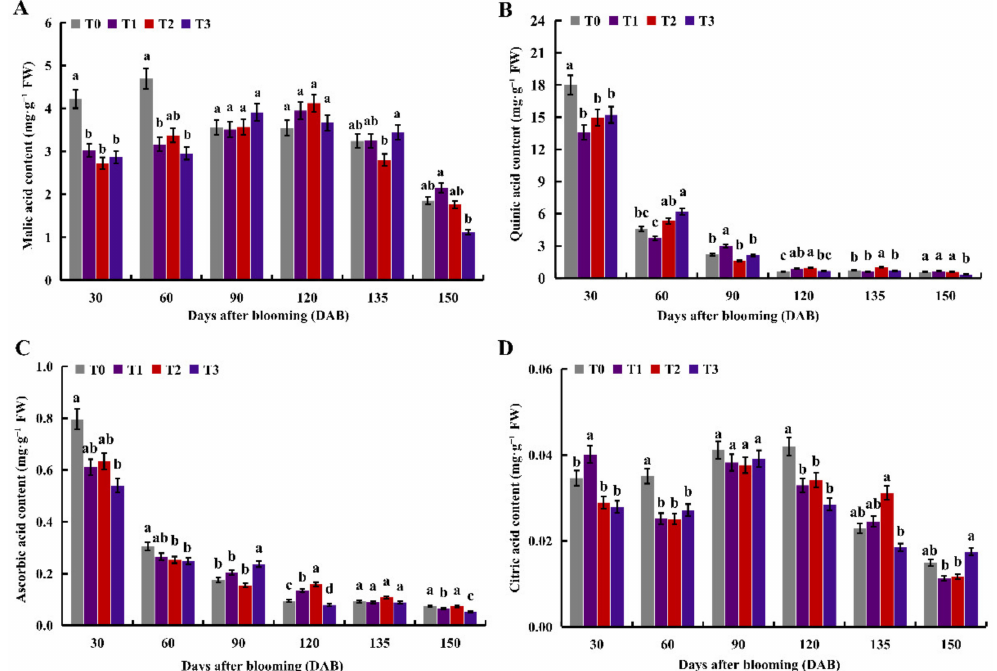
Figure 2. Effect of different nitrogen levels on organic acid in apple fruit. ( A – D ) Malic acid, quinic acid, ascorbic acid, and citric acid content at 30, 60, 90, 120, 135, and 150 DAB, respectively. Different letters in the same period indicate significant differences between different treatments at the 0.05 level ( p <